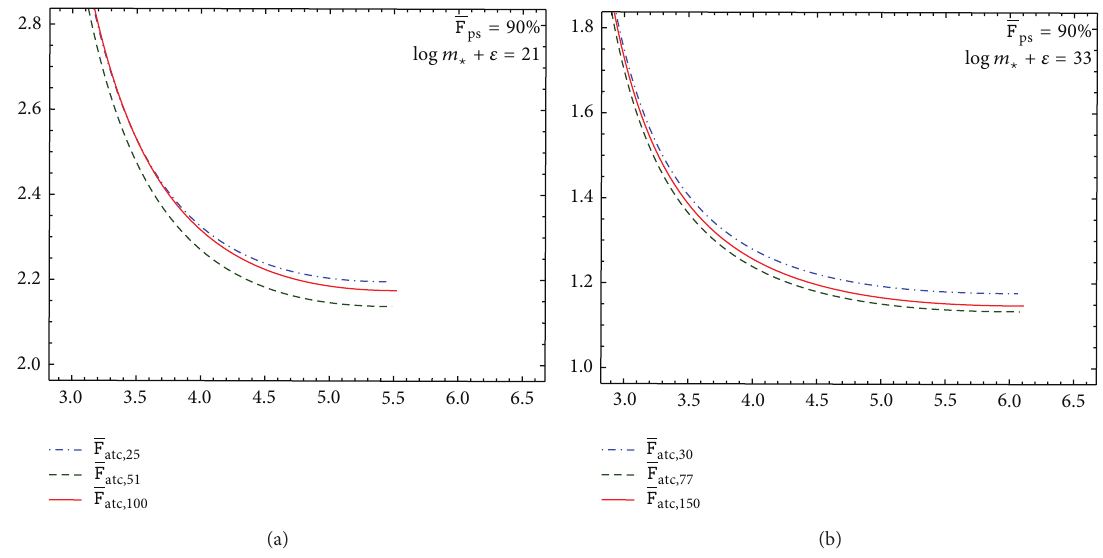
Figure 1: The adjusted tradeoff coefficient F rate 90 % and with log 𝑚 ⋆ + 𝜀 fixed to 21 and 33 (bottom: F